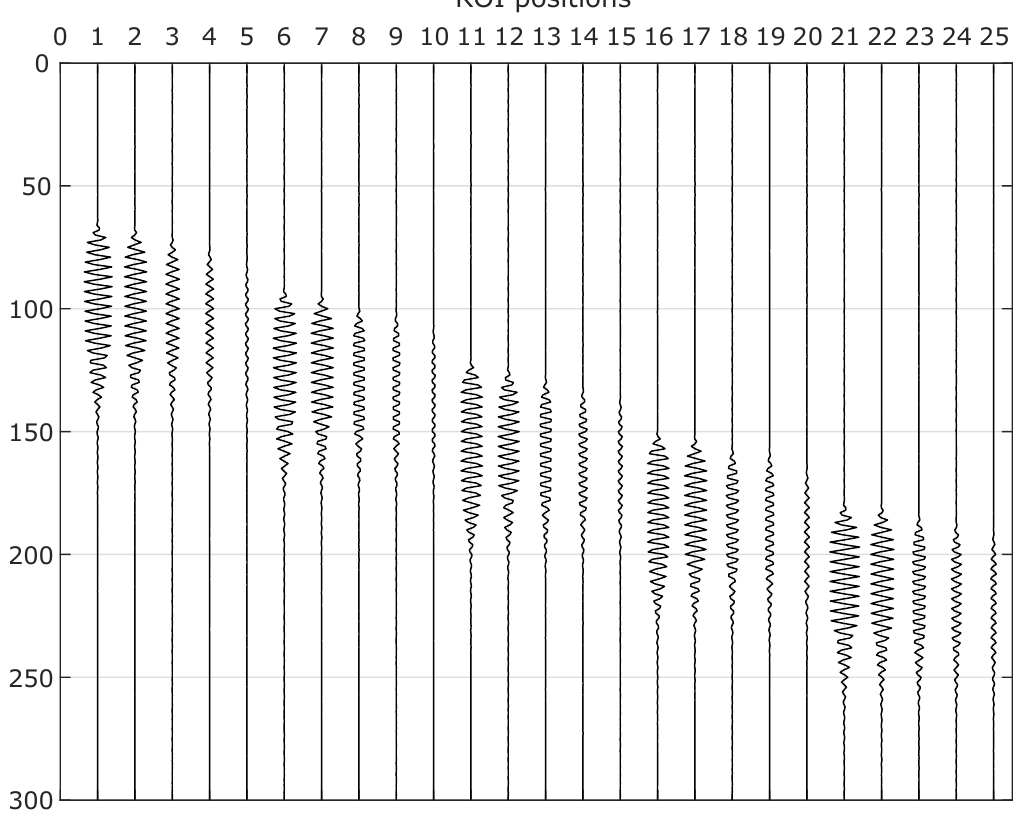
Figure 4. Linear system identification: the H matrix is constructed with the PSF for a single obstacle placed in each ROI position.